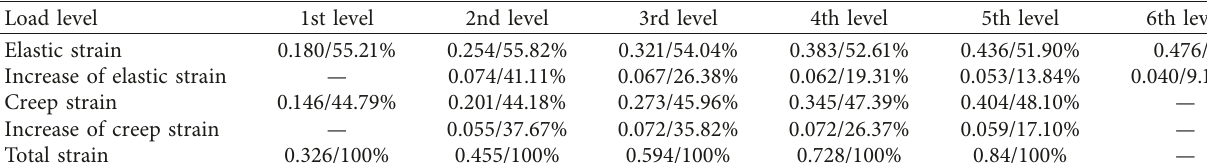
Table 4: Load value of 1st to 6th level.